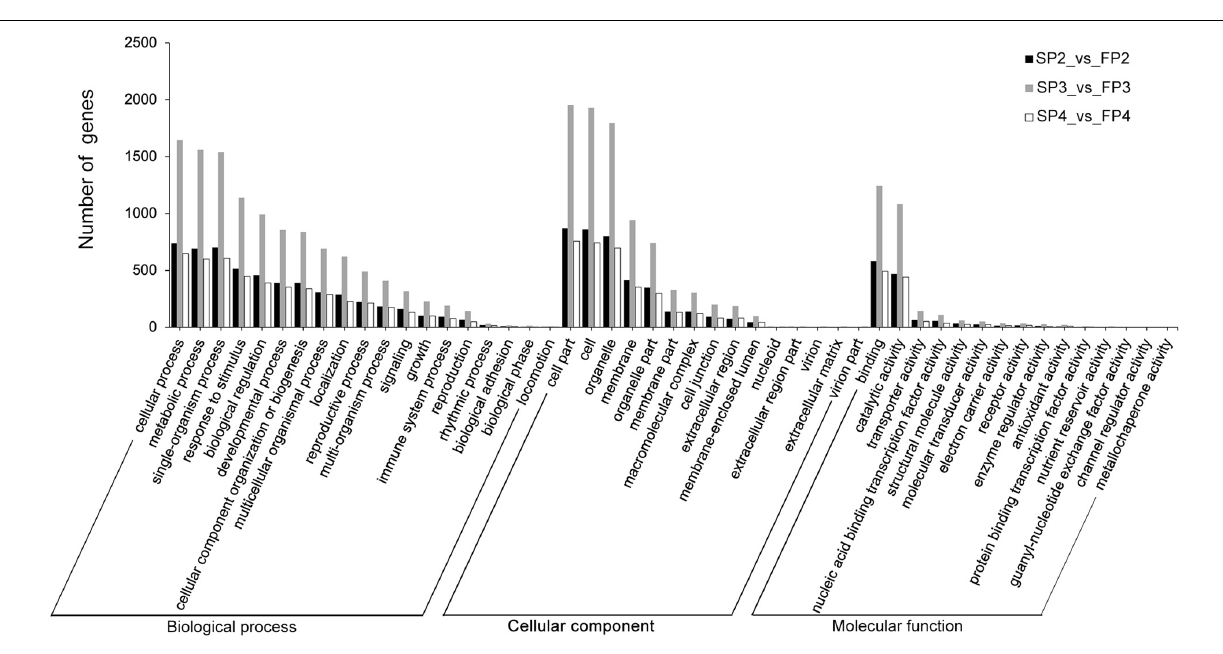
FIGURE 5 | GO enrichment of the cis - and trans -target genes of DE-lncRNAs. The data shown on the left are sorted by number of target genes of DE-lncRNAs at P2, P3, and P4 stages, respectively. The black bars show the number of target genes expressed at the P2 stage; the gray bars show the number of target genes expressed at the P3 stage, and the white bars show the number of target genes expressed at the P4